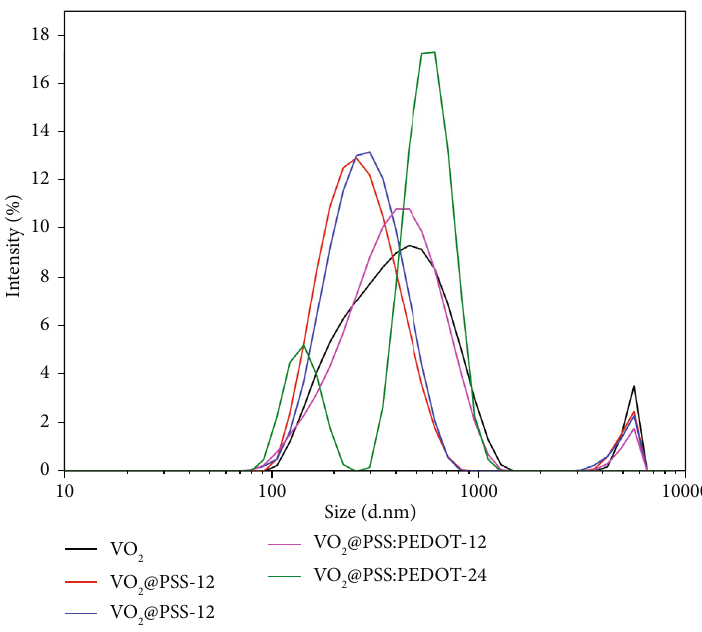
Figure 7: DLS intensity size distribution curves for VO Table 2: Parameters from DLS analysis of VO